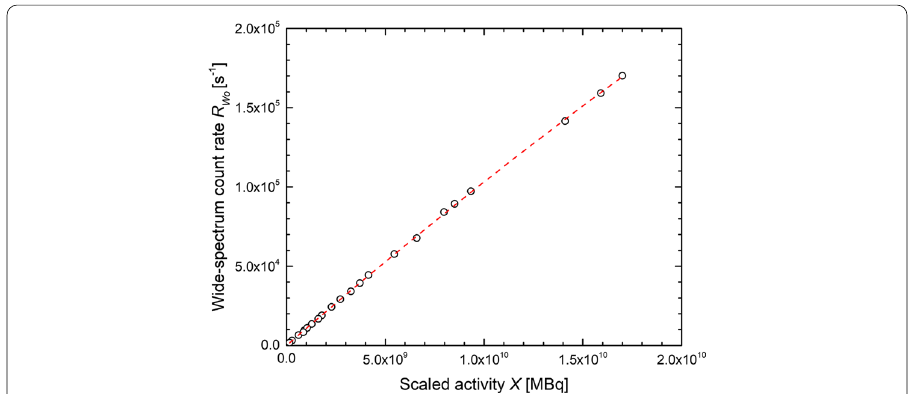
Fig. 3 Data and fit for calibration of Siemens Symbia T16 scanner